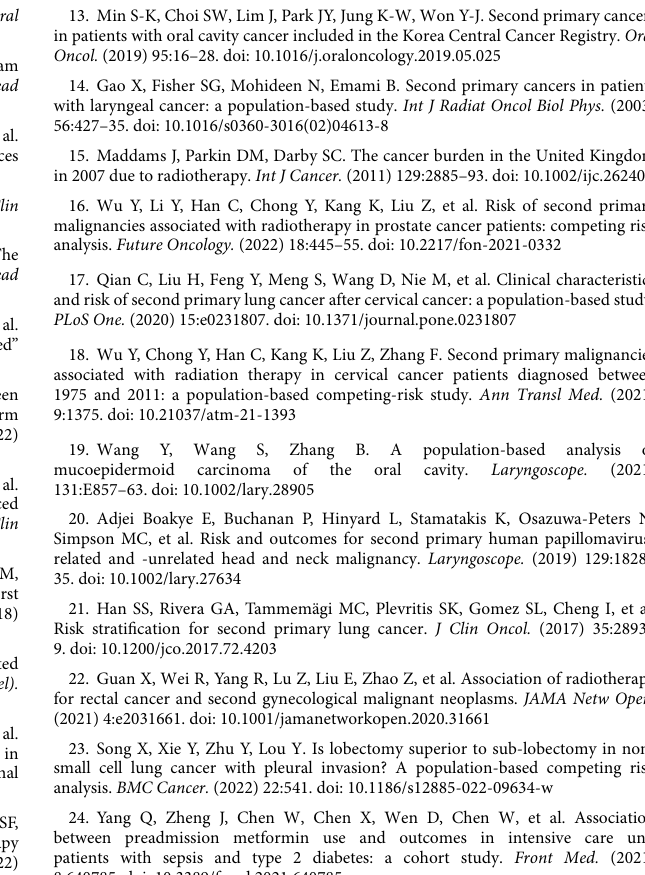
SUPPLEMENTARYTABLES1 Poisson regression model for developing SLC in OCC. SUPPLEMENTARYTABLES2 Subgroup analyses of competing risk regression for the risk of developing SLC. SUPPLEMENTARYTABLES3 Baseline characteristics of patients with SLC in the original/matched data set. SUPPLEMENTARYTABLES4 Baseline characteristics of patients with SLC and matched PLC in